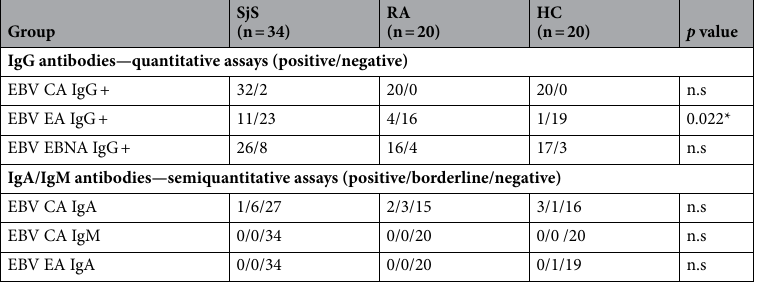
with G1 patients showing higher ESSDAI scores than G2 patients. The lowest ESSDAI scores were observed in G3 patients. Skin involvement was more frequent in G2 patients. Parotid enlargement and Raynaud’s phenomenon